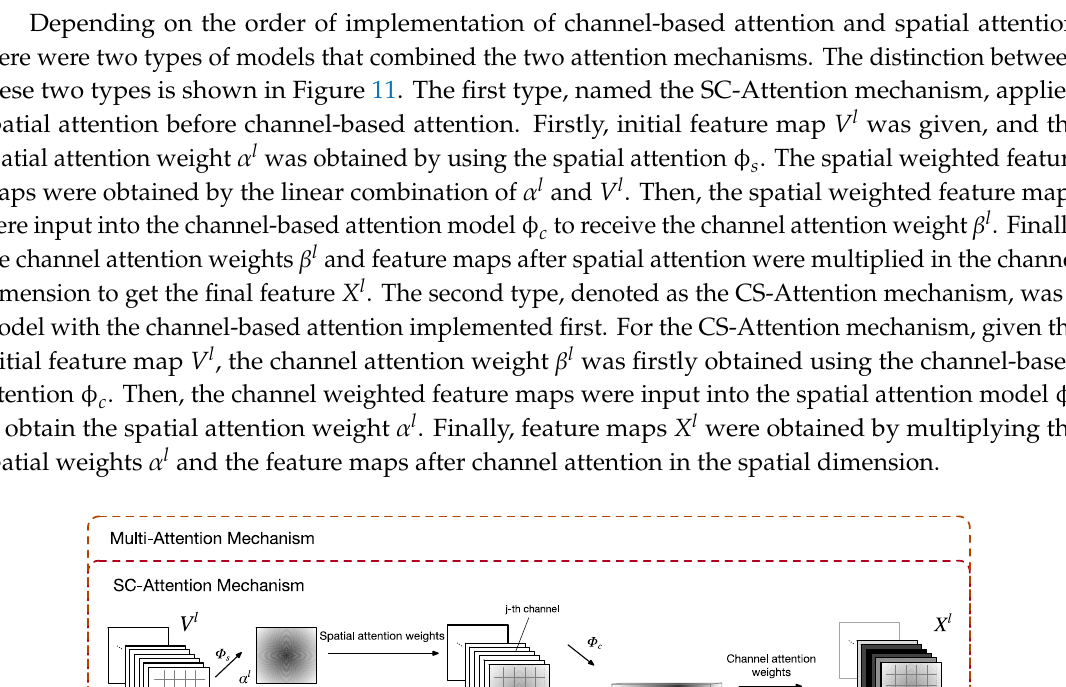
Figure 10. The results of fault identification using the proposed MA-MSCNN with different kinds of single attention mechanism.